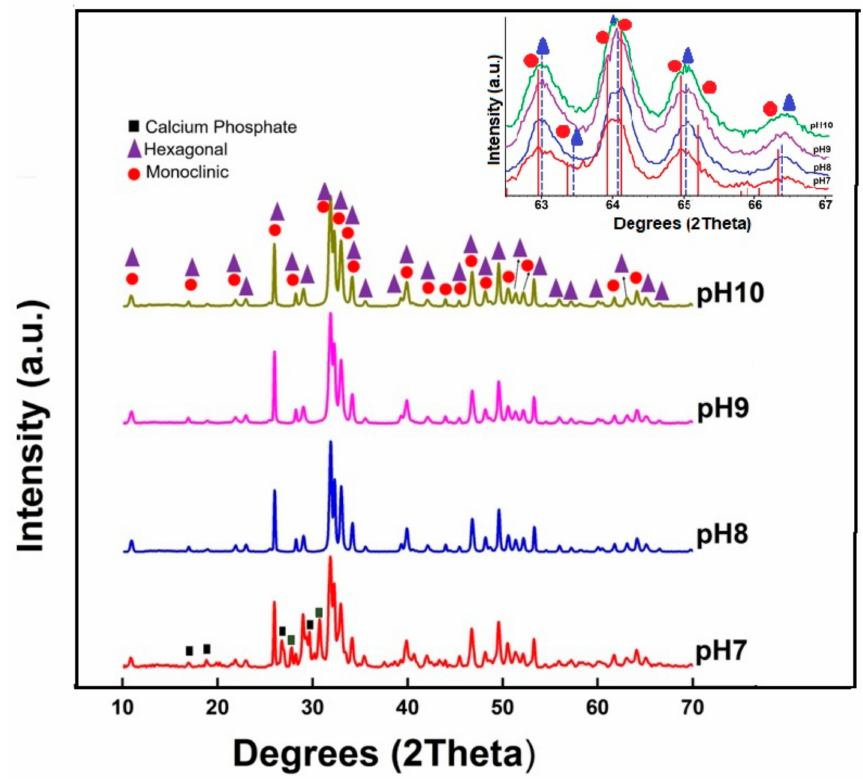
Figure 3. X-ray diffractograms of the HAp nanopowders synthesized at different initial pH conditions showing the presence of the calcium phosphate ( (cid:4) ), hexagonal ( (cid:78) ) and monoclinic ( (cid:108) ) HAp phases for the sample synthesized at pH = 7. Samples synthesized at pH 8, 9, and 10 showed only the presence of the monoclinic and hexagonal HAp phases. Insert: magnified region, from 62.5 ◦ to 67.0 ◦ , to appreciate the individual diffraction peaks of the monoclinic and hexagonal HAp crystalline